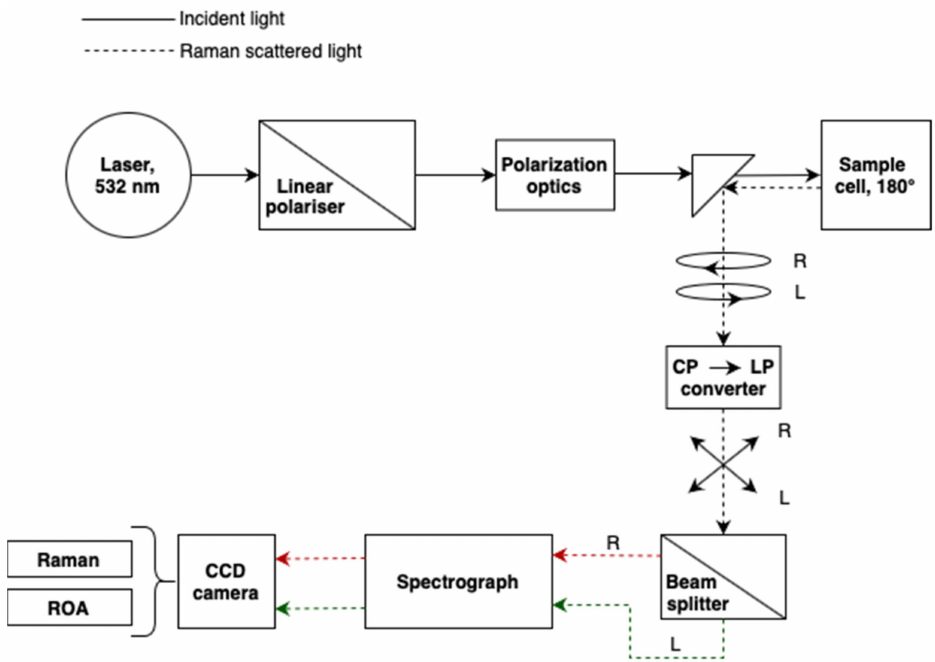
Figure 3. Block diagram of an SCP-ROA instrument using the backscattering (180°) strategy. See text for definitions of the used abbreviations.